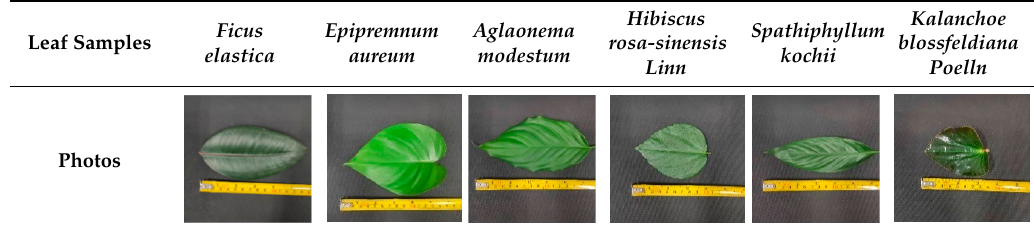
Table 1. Leaf samples and corresponding pictures.